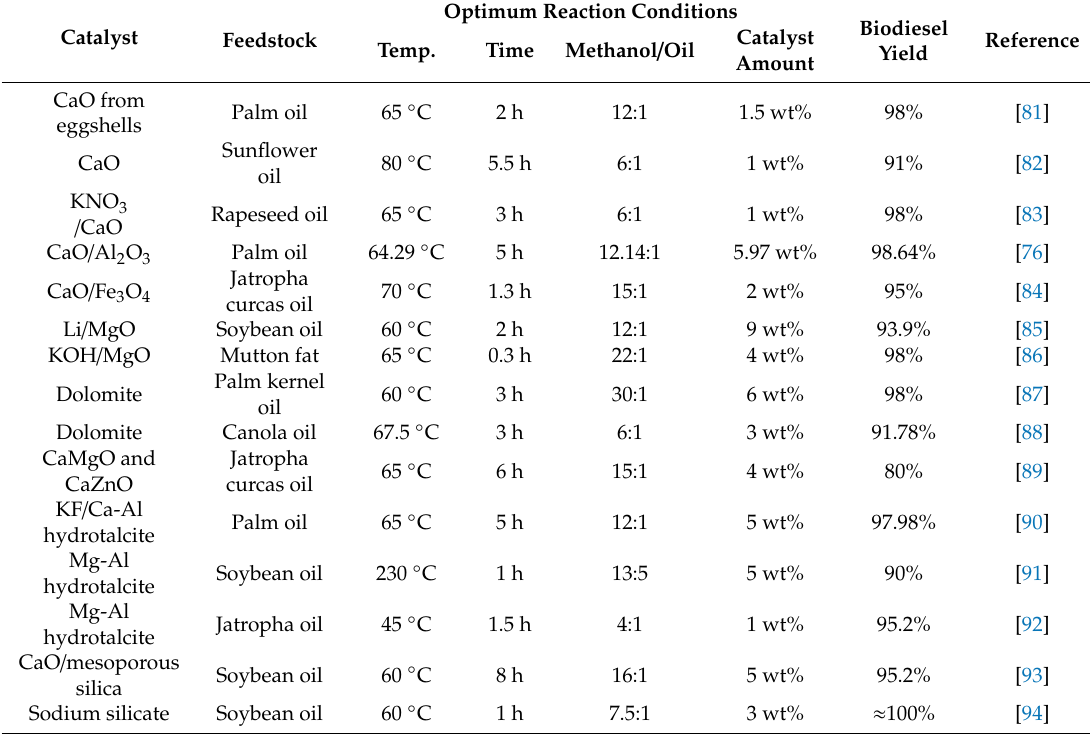
Table 1. Catalysts utilized as basic solids for transesterification